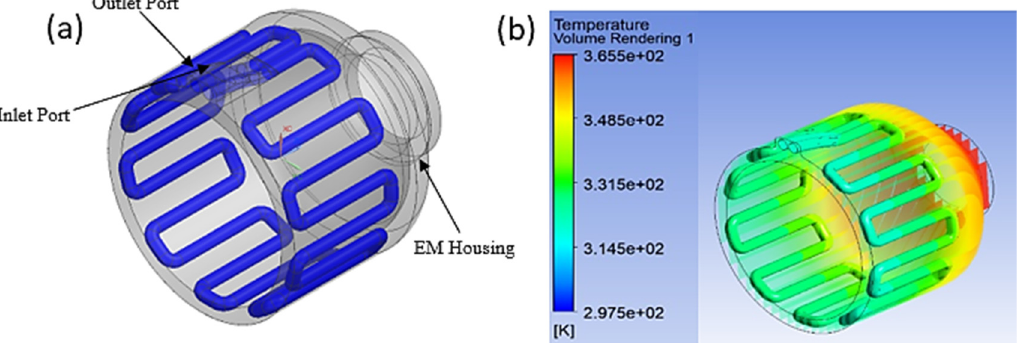
Figure 10. ( a ) CAD Geometry of axial water-cooling jacket. ( b ) Motor housing temperature distribution with axial water jacket.